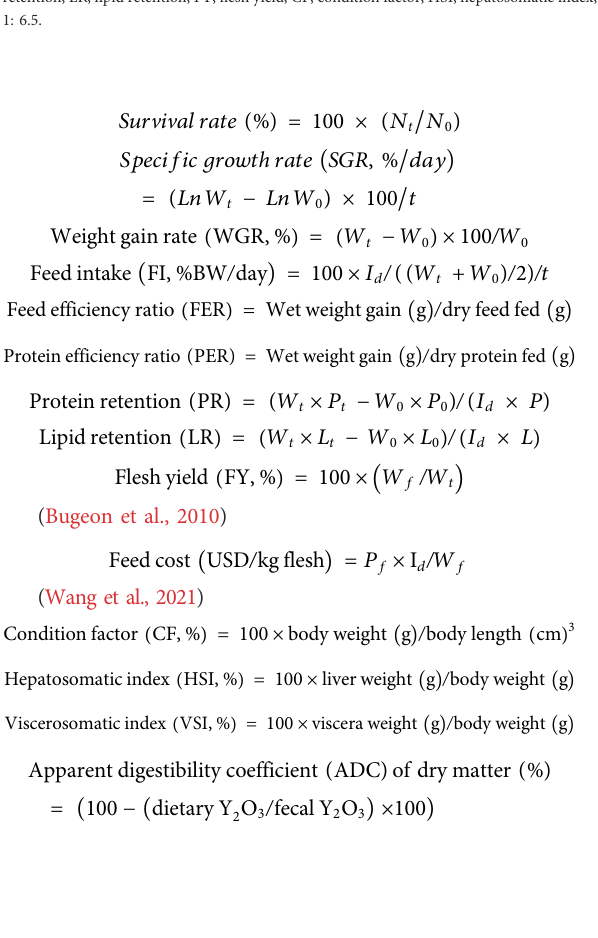
Where W 0 , W t and W f represent initial body weight, fi nal body weight and fl esh weight, respectively. BW is short for body weight. t is duration of the growth experiment. I d is feed consumption. P 0 , P t and P represent protein content in initial fi sh body, fi nal fi sh body and diet, respectively. L 0 , L t and L represent lipid content in initial fi sh body, fi nal fi sh body and diet, respectively. P f stands for feed price that is calculated based on feed ingredient cost. N 0 and N t are initial and fi nal number of fi sh, respectively.